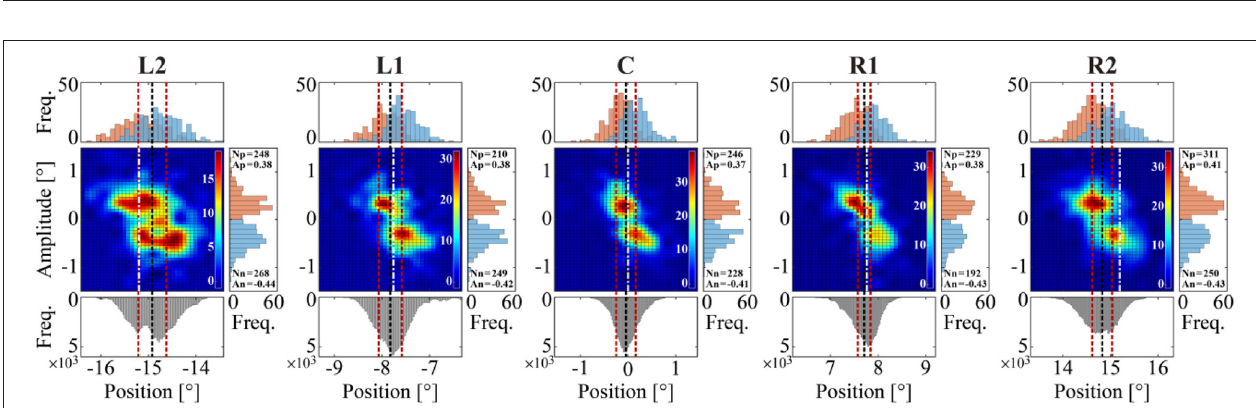
peaks of the histograms (in the upper side of the color maps)